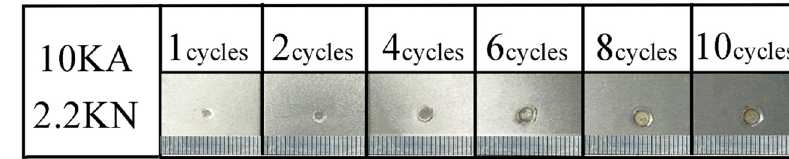
Figure 3: Macro photographs of the resistance spot welded joints in di ff erent con fi gurations.